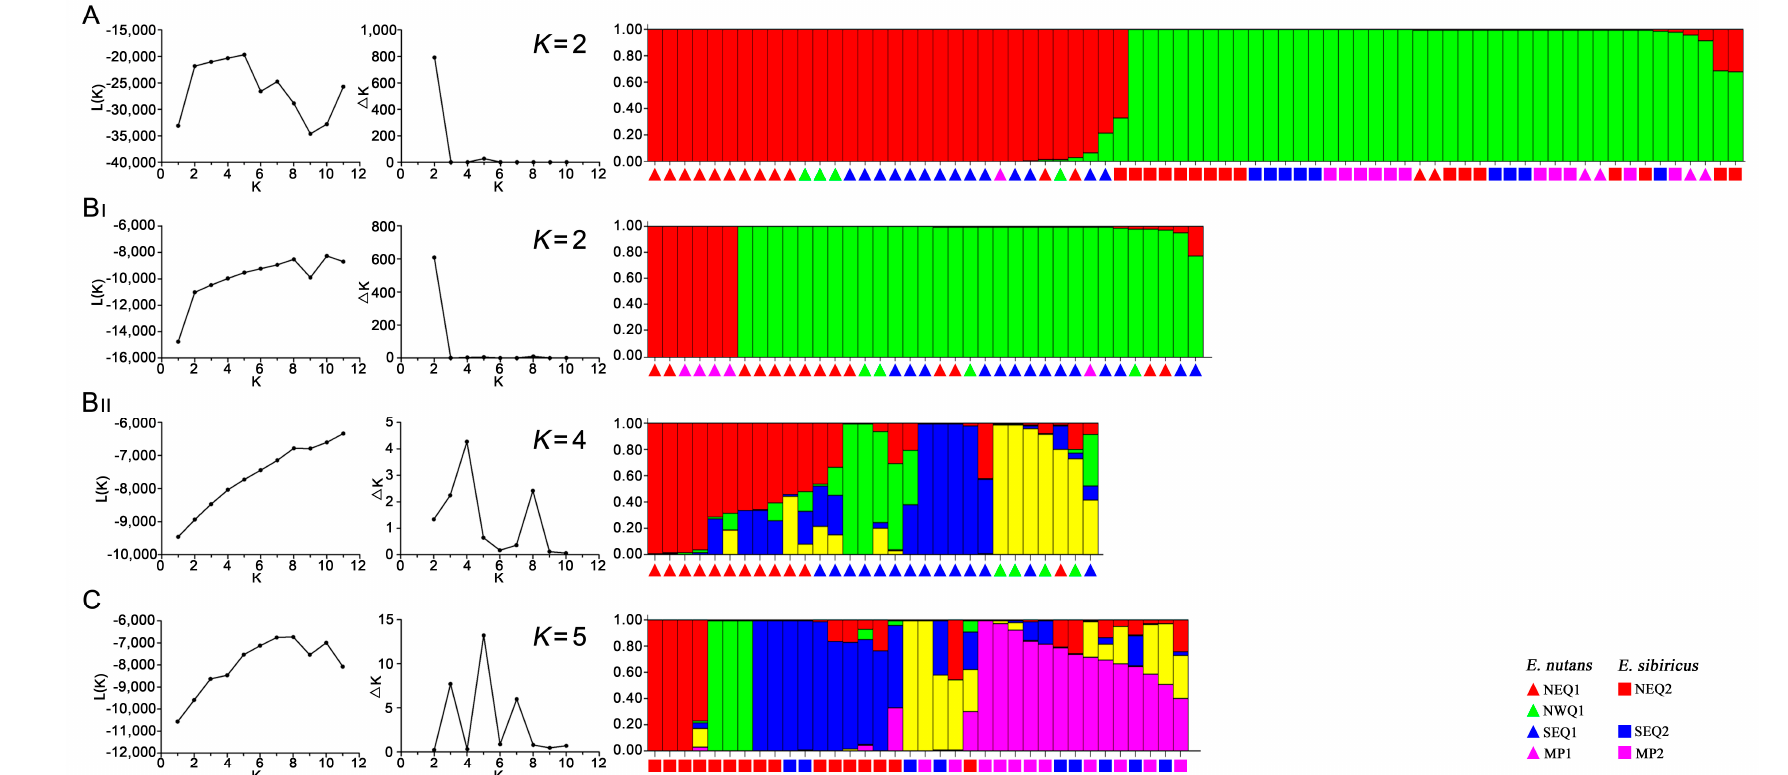
Figure 4. Population structure of 73 Elymus accessions based on Bayesian inferred from STRUCTURE program with 40 EST-SSR markers data set. Each structure was described by using two graphics of the process to detect the optimum K value. One was the mean L ( K ) over 20 runs for each K value (1–11), another was the maximum delta K values used to determine the uppermost level of structure for K ranging from 2 to 10. Different code and corresponding vertical lines represent an individual genotype and different colors represent genetic stock. ( A ) 73 accessions were clustered into two groups at K = 2. Red zone: 31 E. nutans accessions and 1 E. sibiricus accessions; Green zone: 35 E. sibiricus accessions and 6 E. nutans accessions; ( B I ) E. nutans accessions were clustered into two groups ( K = 2); ( B II ) E. nutans accessions from QTP were clustered into four groups ( K = 4); and ( C ) E. sibiricus accessions were clustered into five groups ( K = 5).